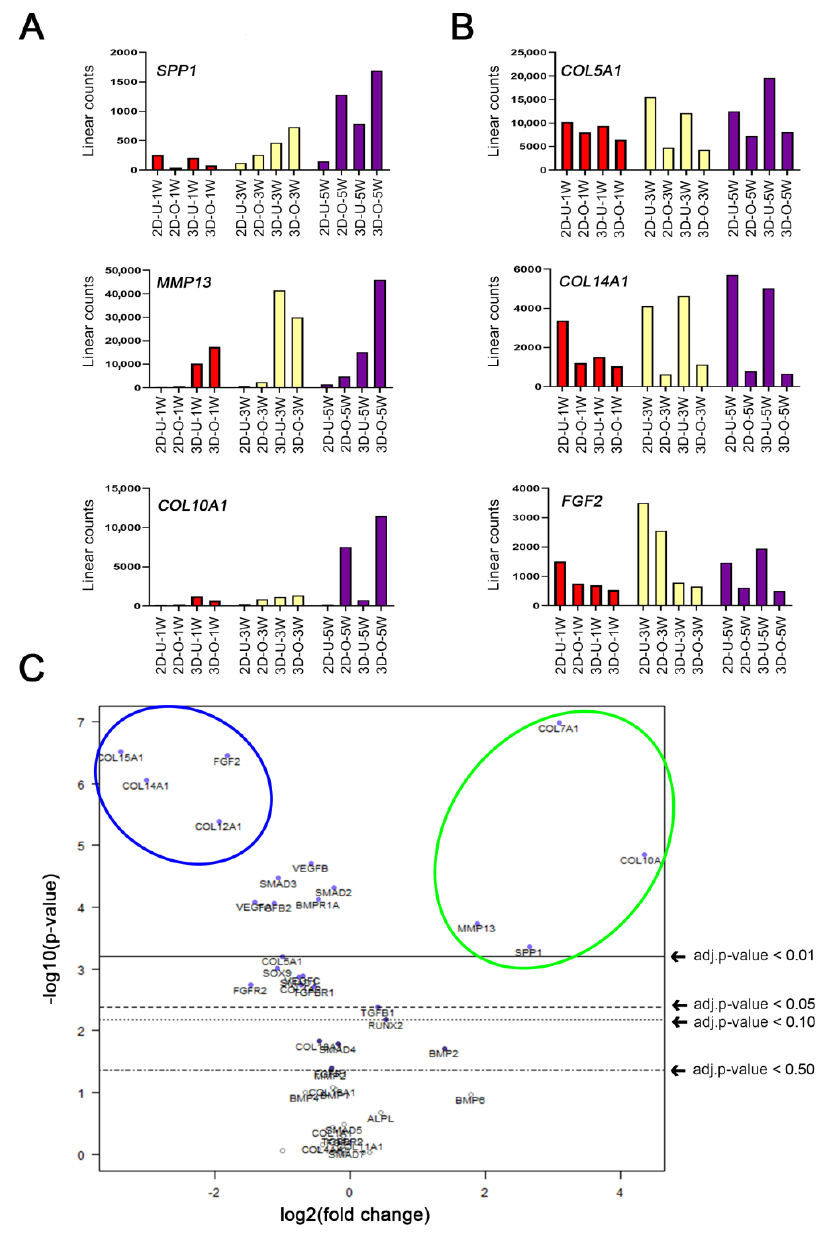
Figure 4. Time course and quantitative analysis of osteogenic gene expression. ( A , B ) Time course of pooled RNA samples from four different donors were screened by a NanoString ® kit for 66 (mainly osteogenic) genes after 1, 3 or 5 weeks of control or osteogenic condition. Week timepoints are shown as W1 (red), W3 (yellow), W5 (purple). Meanings: 2D = ad- herent cell cultures, 3D = Col I gel cultures, U = Undifferentiated cells in control medium, and O = differentiated cells in osteogenic medium. ( A ) Time course of the three most upregulated out of sixty-six tested genes: SPP1, MMP13, COL10A1. ( B ) Time course of the three most downregulated out of sixty-six tested genes: COL5A1, COL14A1, FGF2 . ( C ) Multivariate analysis of the sixty-six tested genes, after 5 weeks of differentiation, displayed as a volcano plot (created with nSolver ®